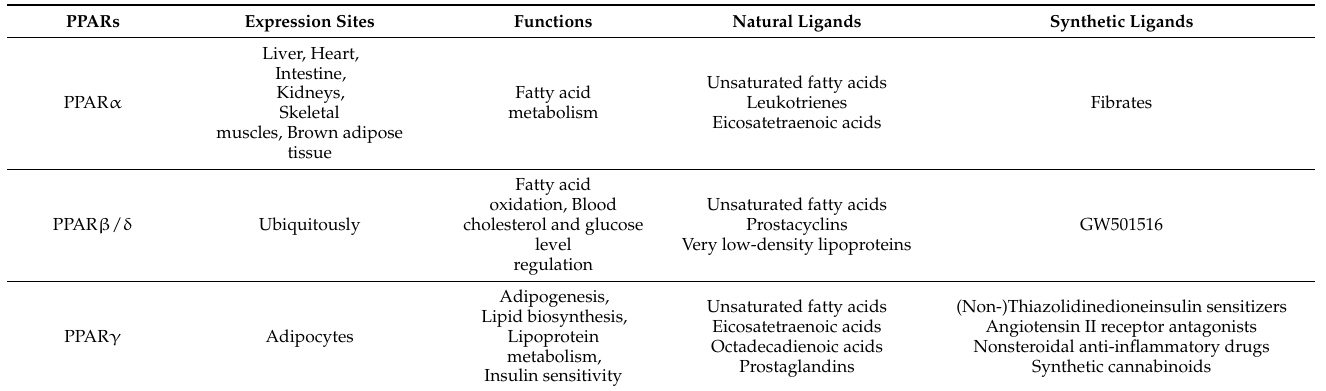
Table 1. Expression sites, functions and ligands of